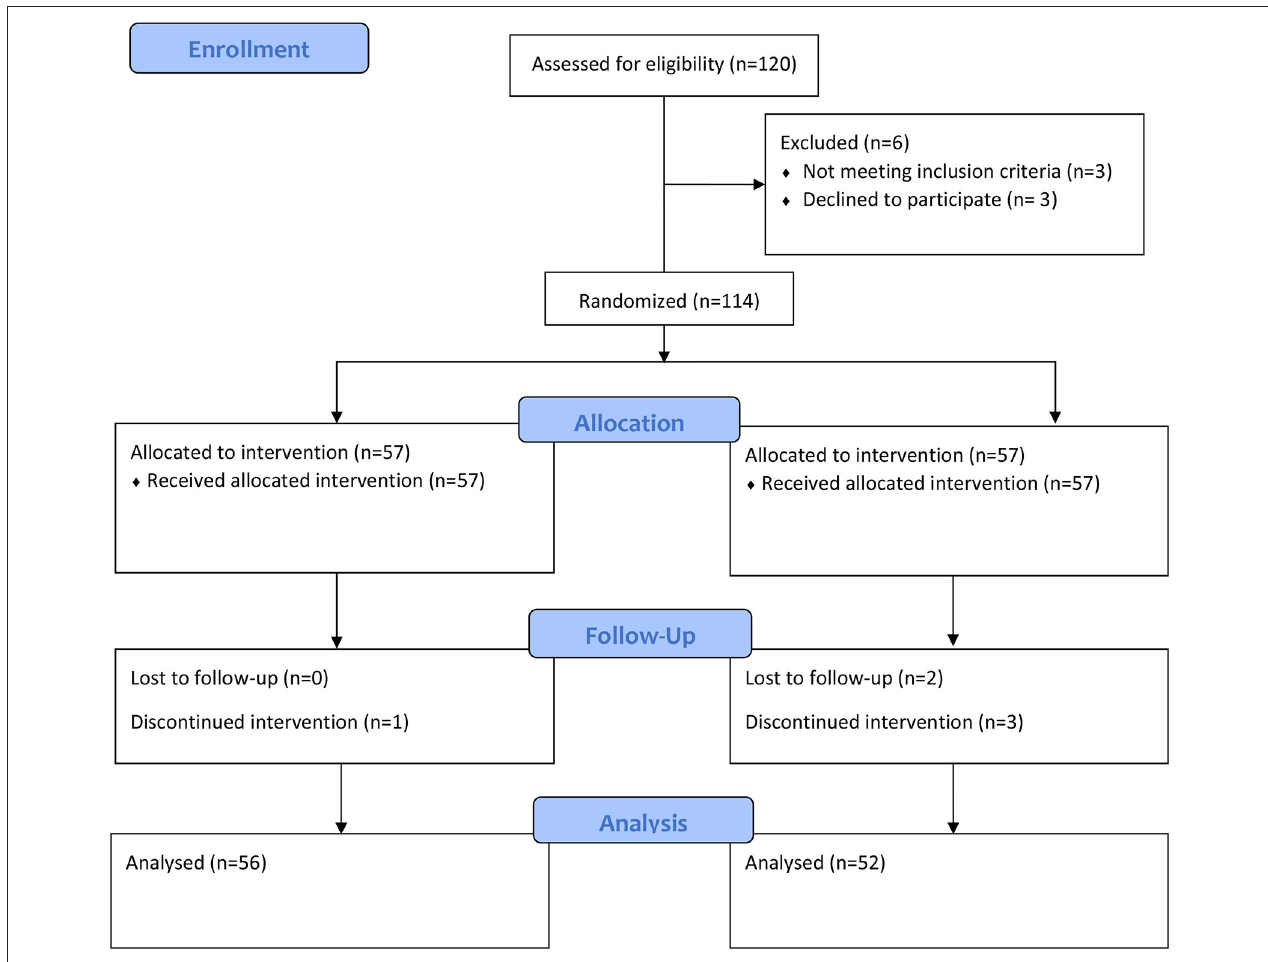
FIGURE 1 | Consort flow diagram of patient